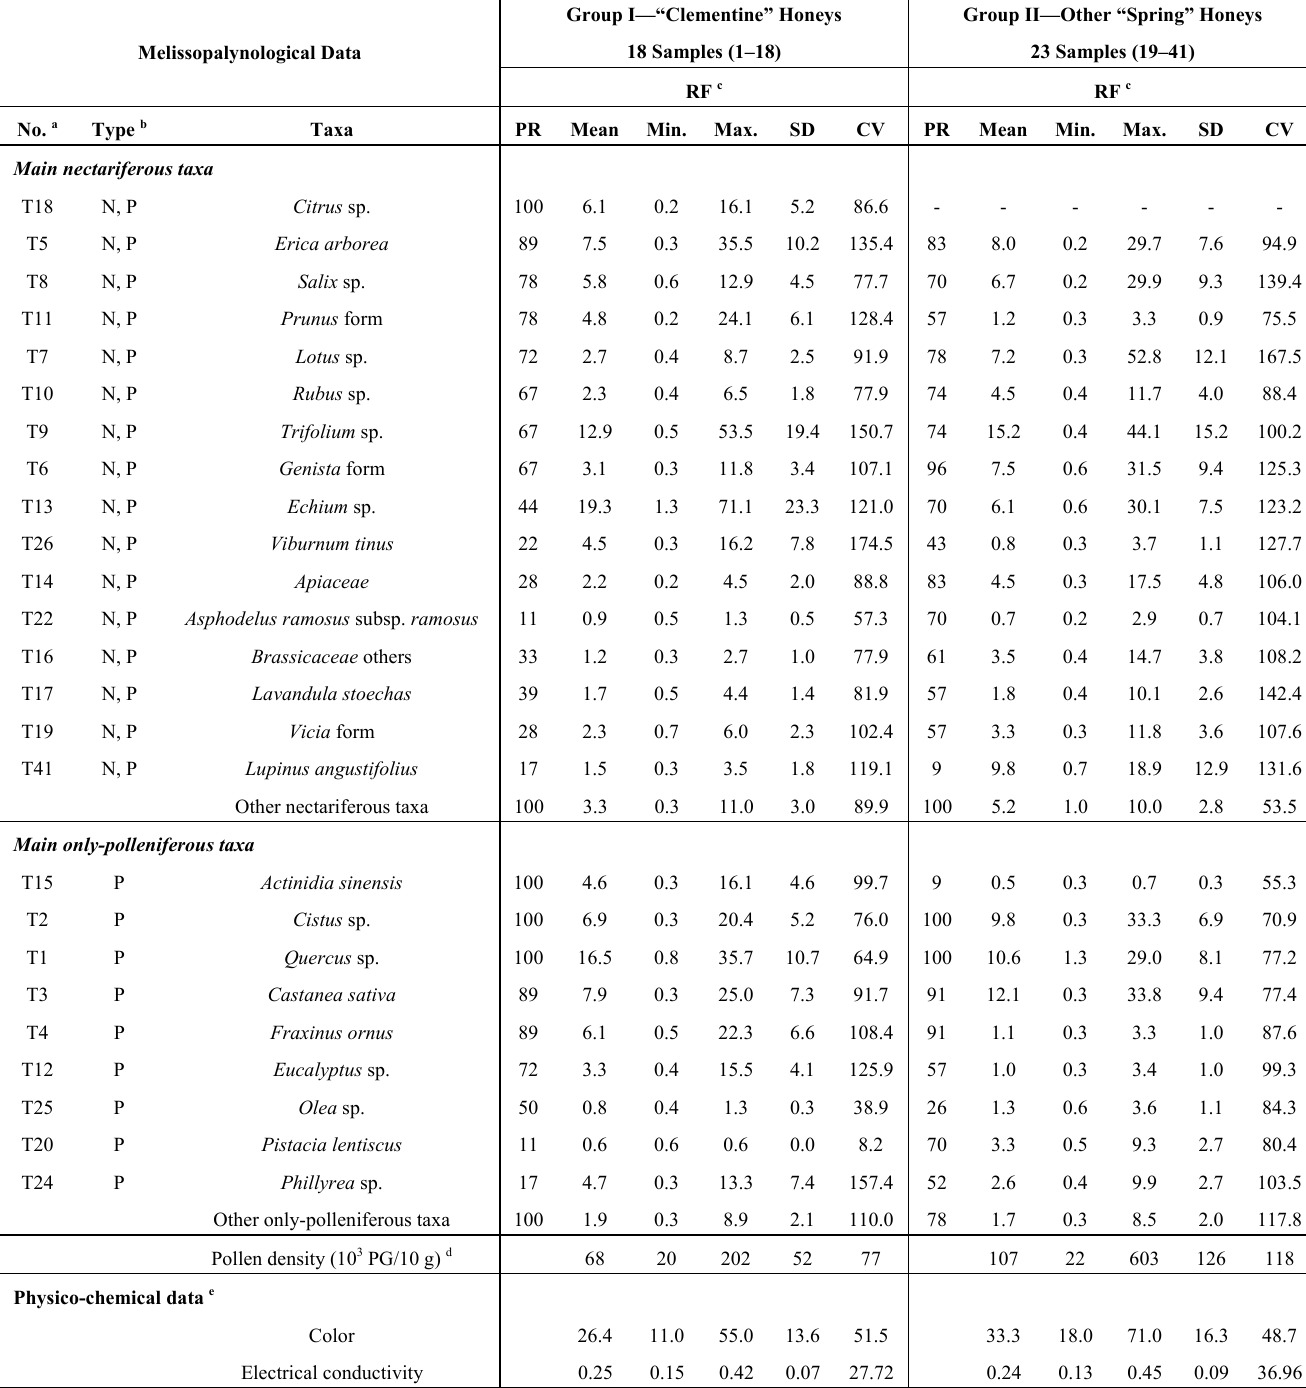
Table 2. Melissopalynological and physico-chemical characteristics of Corsican “clementine” honeys and other “spring” honeys. Melissopalynological